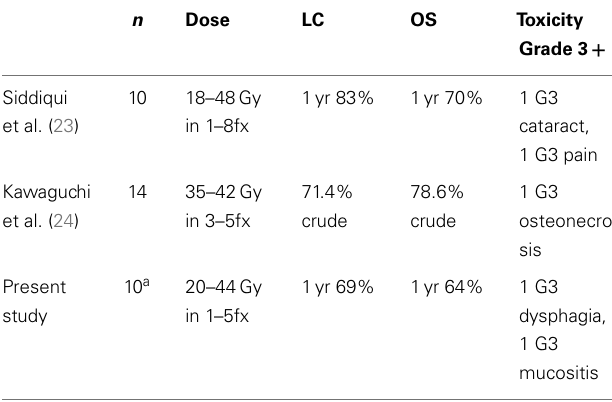
Table 4 | Summary of data for primary SBRT in elderly patients